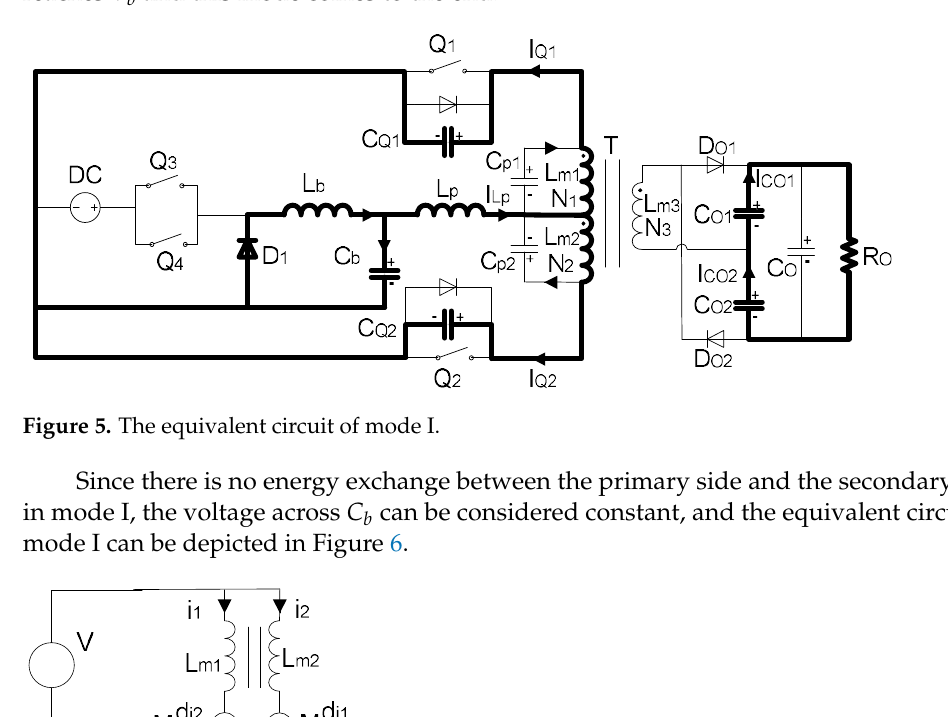
Figure 4. The key waveforms in a complete switching cycle.